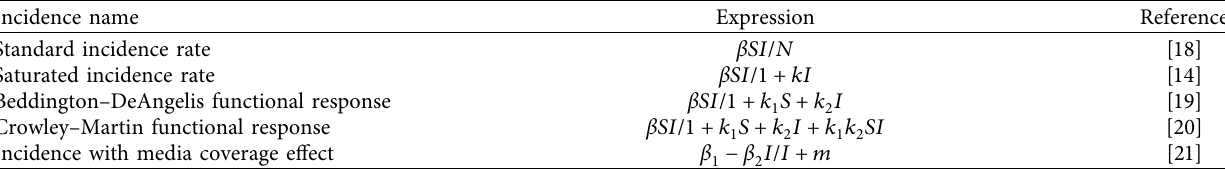
Table 1: Some nonlinear incidence